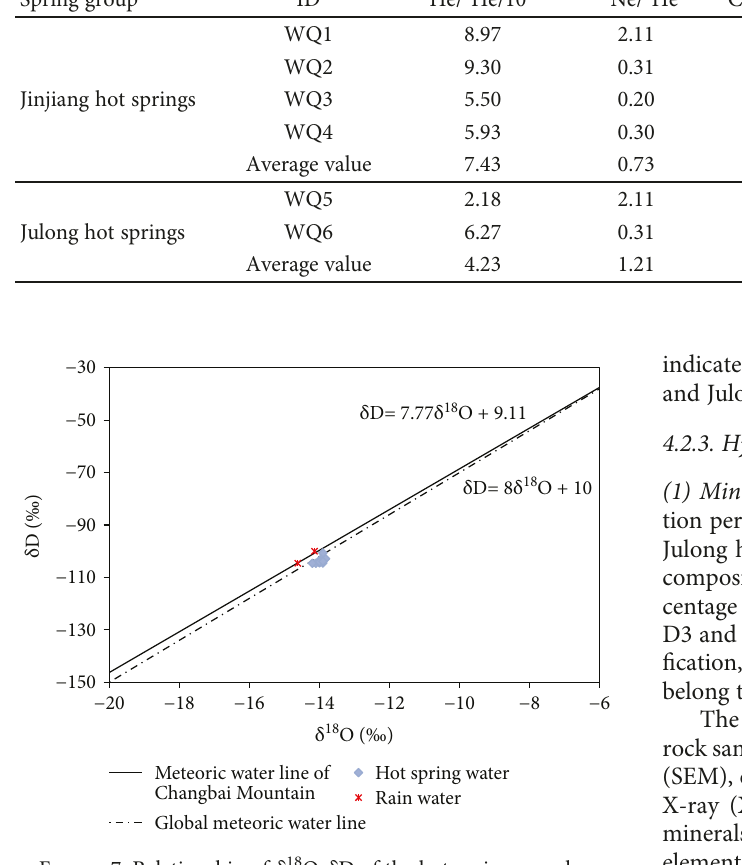
values of the upper mantle ranged from 2